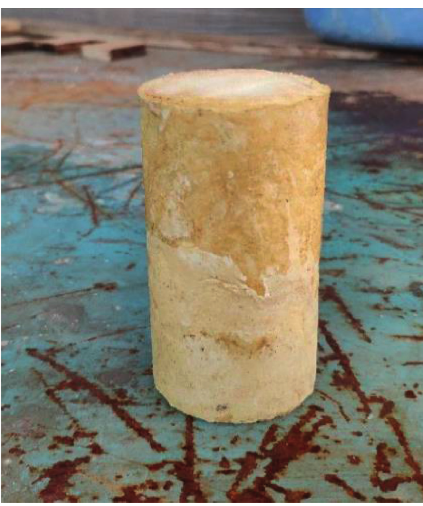
Figure 2: Grout Table 4: Test results of grout density.